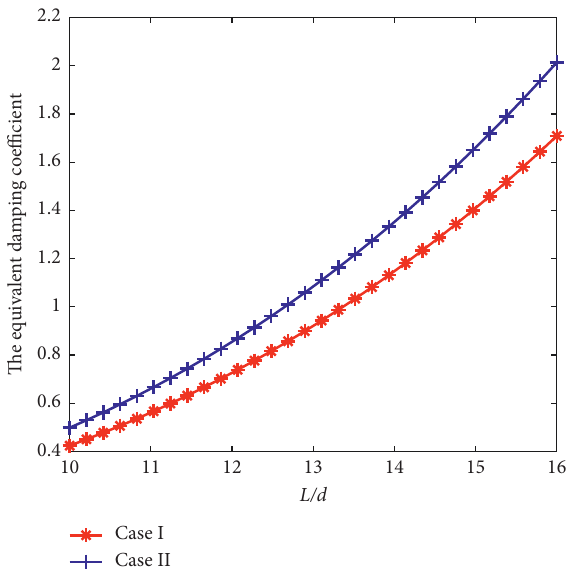
Figure 34: The equivalent damping coefficients versus ratio of length to diameter for cases I and